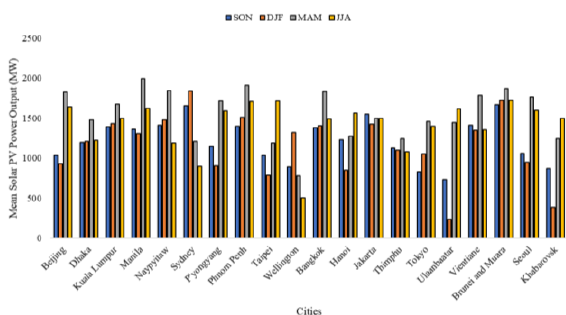
Figure 3. Theoretical mean seasonal solar PV power ( P PV ) output for selected cities in the Asia Pacific